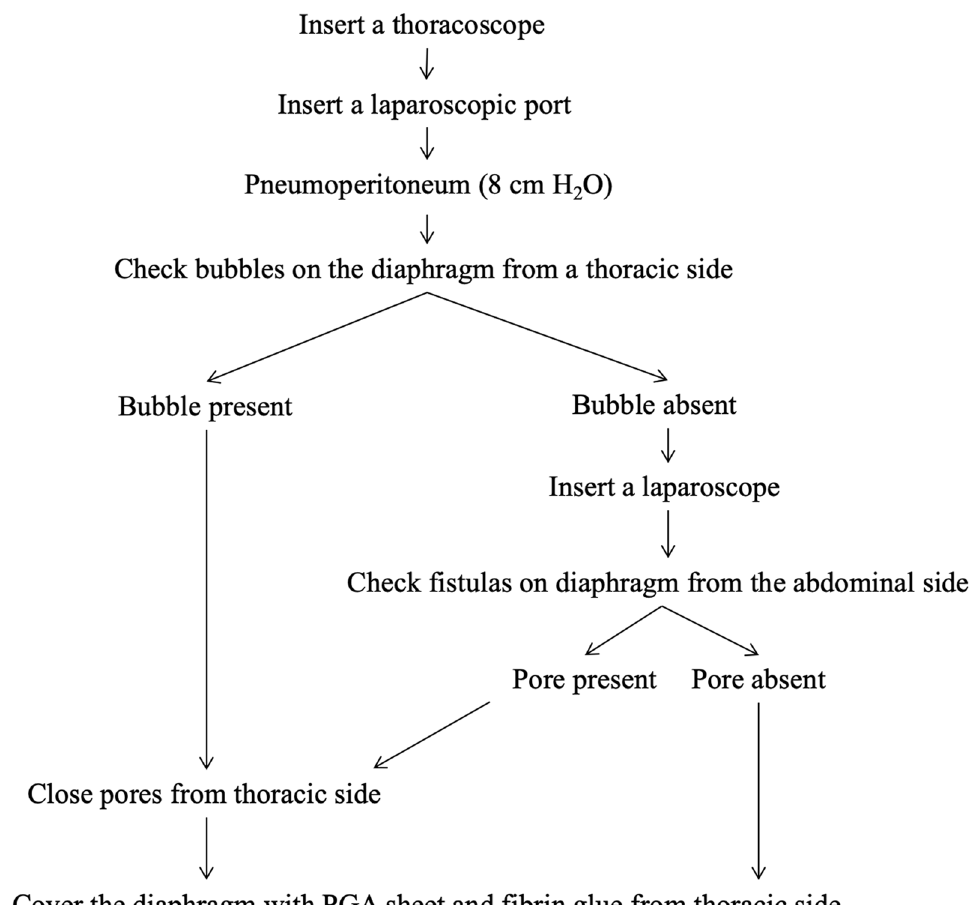
Fig. 1 Surgical treatment strategy for pleuroperitoneal